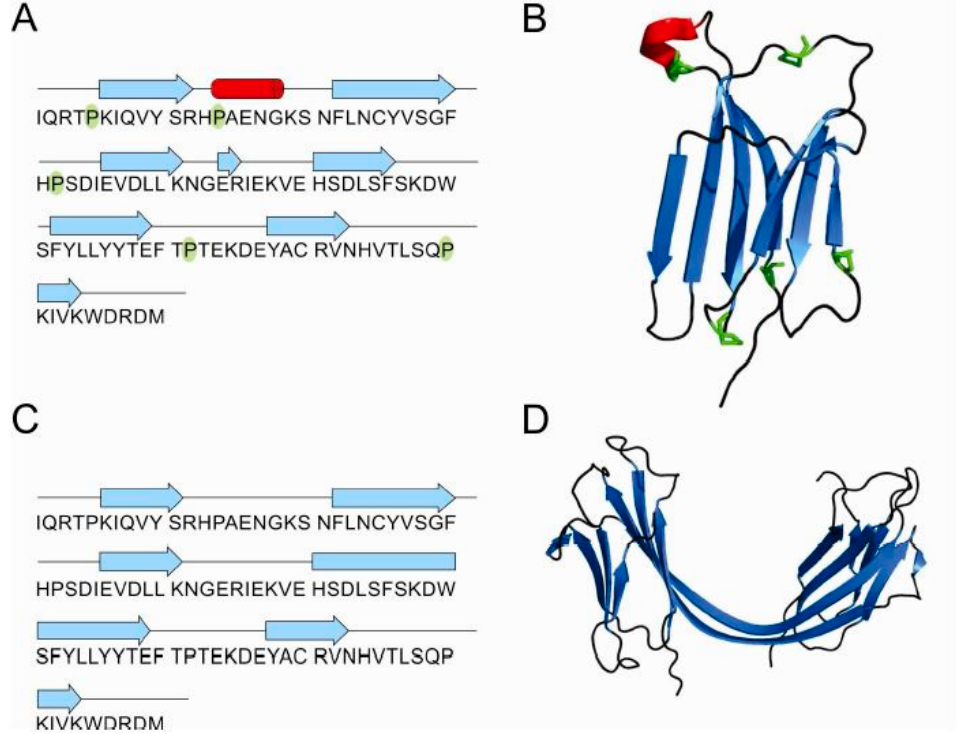
Figure 6. β 2 -microglobulin schematic presentation of secondary structure elements and the 3D structure of monomer (PDB id: 1LDS) [88] ( A , B ) and domain-swapped dimer (PDB id: 3LOW) [87] ( C , D ). All five prolines are highlighted in green in the monomer.